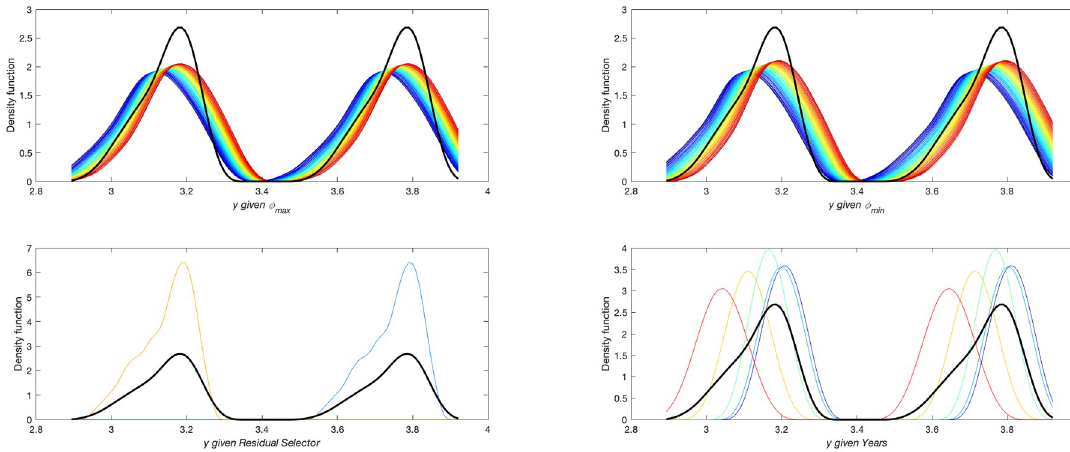
Fig 5. Conditional output distributions for Clb when fixing the uncertain input parameters.